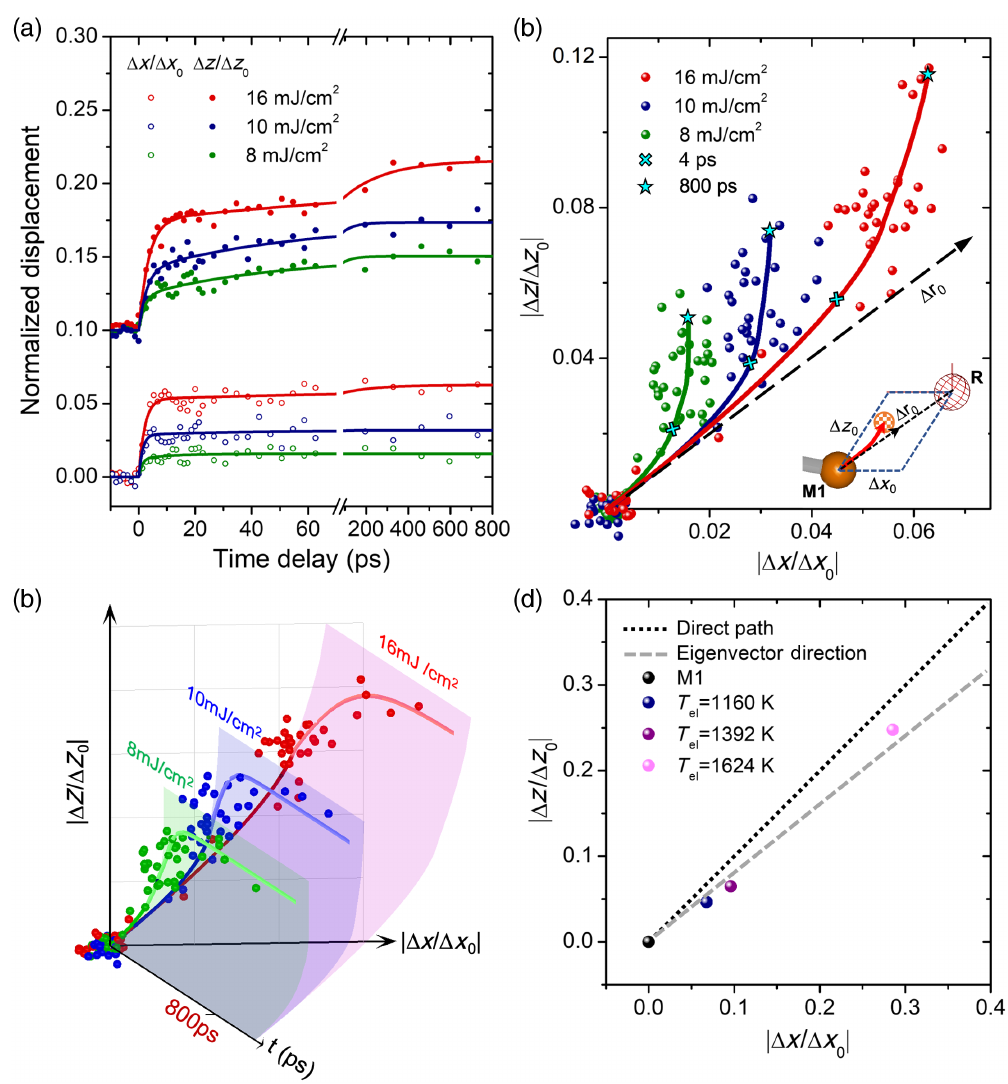
FIG. 3. Correlated vanadium movement upon photoexcitation. (a) The normalized displacement along x and z direction ( j Δ x= Δ x 0 j and j Δ z= Δ z 0 j ) as a function of time delay. The displacement along z is shifted vertically for clarity. (b) A 3D plot of the V displacement induced by photoexcitation as a function of time and fluence. Three color planes are the curved surfaces of the vanadium movement plotted along time axis ( t ¼ 0 – 800 ps) for three different fluences. (c) Normalized displacement j Δ x= Δ x 0 j versus j Δ z= Δ z 0 j for different time delays projected along the time axis from the 3D plot in (b). The black dashed line indicates the direction of V movement from its M1 to R position. Note for clarity the x and z axes are drawn orthogonally. The actual angle between the two is 57.4° (see inset). The V movements in the first few picoseconds are along the Δ r 0 direction. The locations of 4 and 800 ps are marked in the fitting curve. With the increase of time delay, the weight of displacement along the c axis increases, significantly departing from the Δ r 0 direction. Inset: the definition of Δ x 0 , Δ z 0 , and Δ r 0 [see the rectangle box in Fig. 1(a)]. The black arrow points to the straight line path of the Vatom from the M1 position to the R position. The red line depicts the motion path of Vatom under the fluence of 16 mJ = cm 2 with the end point being at t ¼ 730 ps. (d) Calculated j Δ x= Δ x 0 j versus j Δ z= Δ z 0 j plot using four parallel AIMD trajectories at different electronic temperature T . el The average Vatomic positions between − 500 and 0 fs before photoexcitation at 300 K in the AIMD calculations is the origin ð 0 ; 0 Þ . M 1 1160 K agreed well with experimental displacement at 4 ps The relative displacements rely on the T . j Δ x= Δ x 0 j and j Δ z= Δ z 0 j at T el el ¼ under the fluence of 16 mJ = cm 2